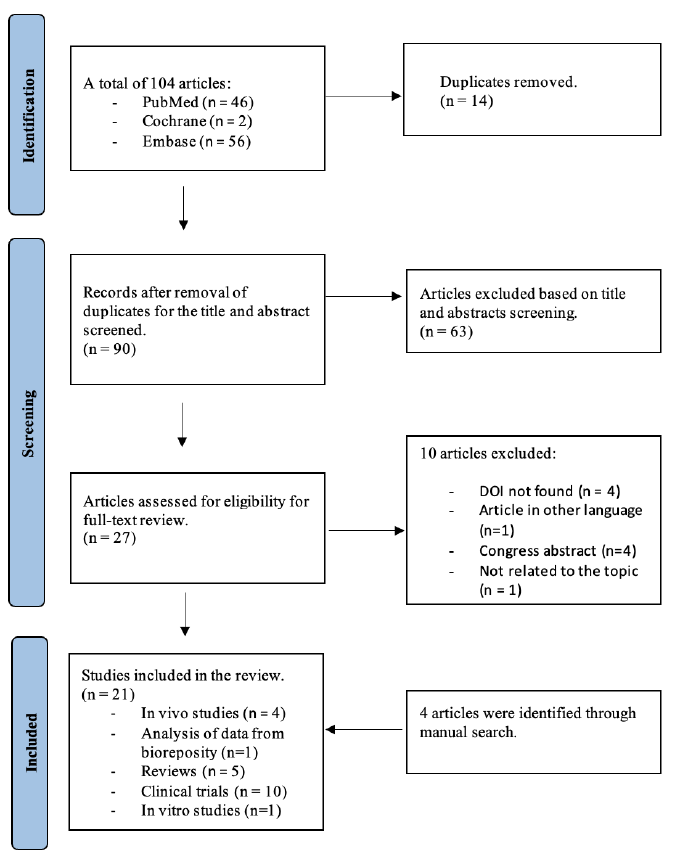
Figure 2. PRISMA flow diagram of the study.